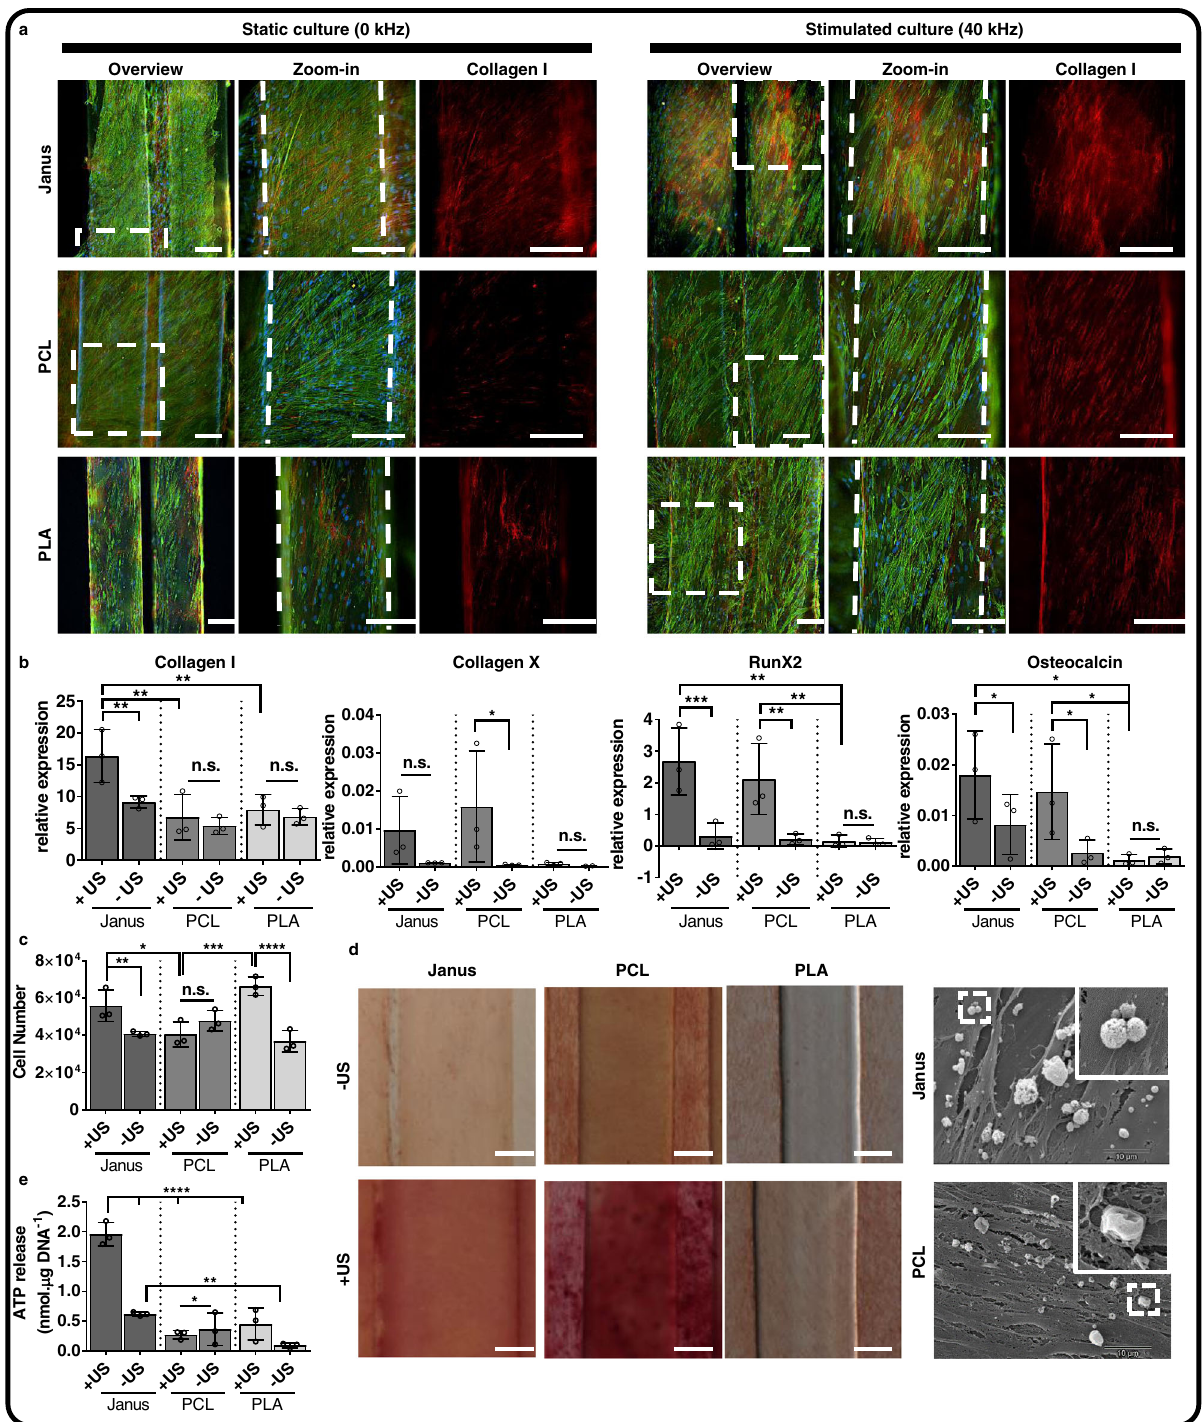
Fig. 4 Osteogenic differentiation is enhanced on cells cultured for 21 days on ultrasound-stimulated Janus scaffolds. hBMSCs were cultured for 21 days on Janus, PCL and PLA scaffolds in osteogenic media and under static (0 kHz, − US) or dynamic conditions (40 kHz, 30 min/day, + US) after which ( a ) collagen I deposition was evaluated from fl uorescence light microscopy images. Cells were stained for F-actin (green), DNA (blue) and Collagen I (red). White dash-line boxes represents the area where the zoom-in was taken and dash lines de fi ne the limits of the fi bers. Scale bars represent 200 µ m. b Collagen I, collagen X, RunX2, and osteocalcin gene expression and cell number ( c ) were also analyzed. d Alizarin red staining (left) showing increased calcium deposition on Janus and PCL scaffolds stimulated with ultrasound compared to static cultures. SEM images (right) showing the characteristic morphology of hydroxyapatite on Janus scaffolds, while deposits on PCL substrates represent Ca + 2 salts. White dash-line boxes represents the area where the zoom-in was taken. Scale bars represent 100 µ m. e Measurement of the ATP on hBMSCs cultured on Janus, PCL and PLA scaffolds. In all the graphs, data is shown as mean ± SD. Black circles are individual data points. n = 3 biological triplicates. Statistical signi fi cance was calculated by ordinary two-way ANOVA with corrected Tukey ’ s multiple comparison test between groups and uncorrected Fisher ’ s LSD between conditions of a same group ( + / − US); **** p < 0.0001, *** p < 0.001, ** p < 0.01, and * p < 0.1. Source data and exact p values are provided as a Source Data fi